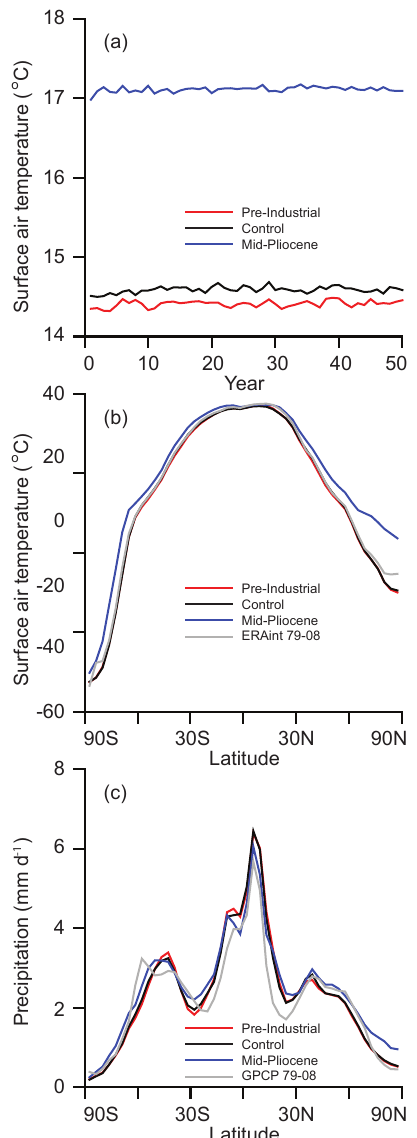
Fig. 4. (a) Time series of SAT ( ◦ C) in the pre-industrial (red line), the control (black line), and the mid-Pliocene (blue line) experi- ment. (b) Simulated zonal mean annual SAT ( ◦ C), with comparison to the ERA-interim temperature from 1979 to 2008. (c) Simulated zonal mean annual precipitation (mm d − 1 ), with comparison to the Global Precipitation Climatology Project (GPCP) 1979–2008 pre-